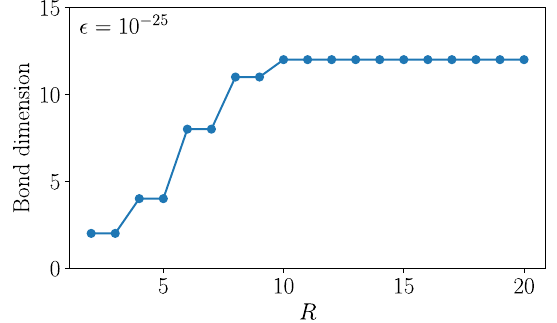
FIG. 4. Bond dimensions of the MPO for the discrete Fourier transform recursively constructed with truncation cutoff ϵ ¼ 10 − 25